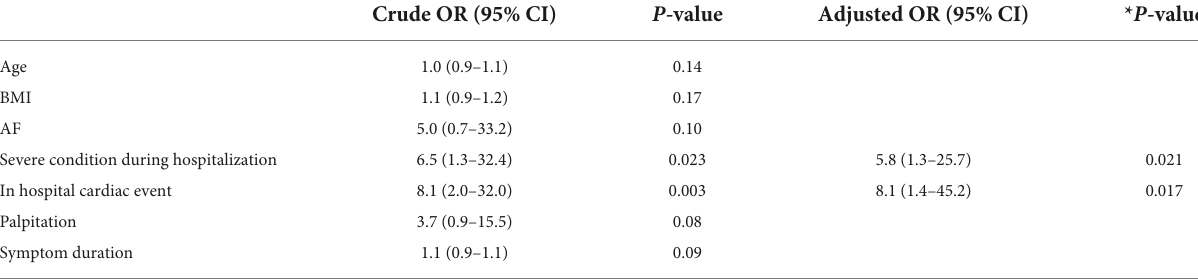
TABLE 2 Logistic regression analysis of cardiovascular disorders in CV long COVID